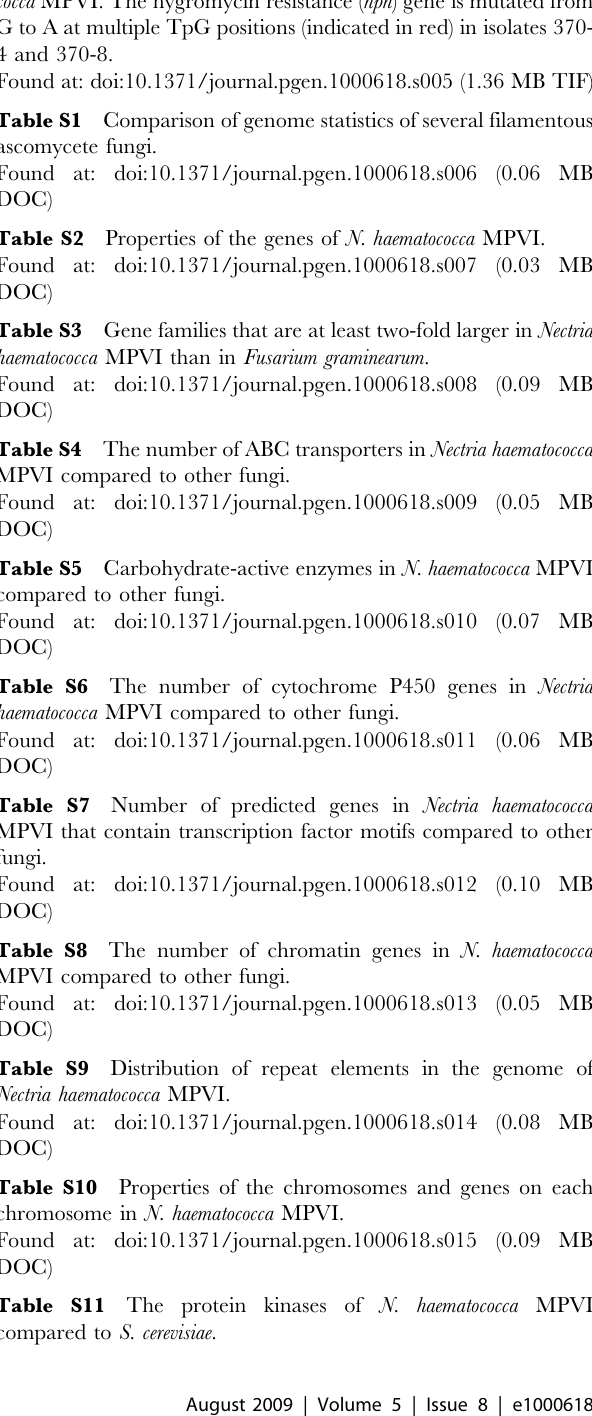
Table S9 Distribution of repeat elements in the genome of Nectria haematococca MPVI. DOC) Table S10 Properties of the chromosomes and genes on each chromosome in N. haematococca MPVI. DOC) Table S11 The protein kinases of N. haematococca MPVI compared to S. cerevisiae